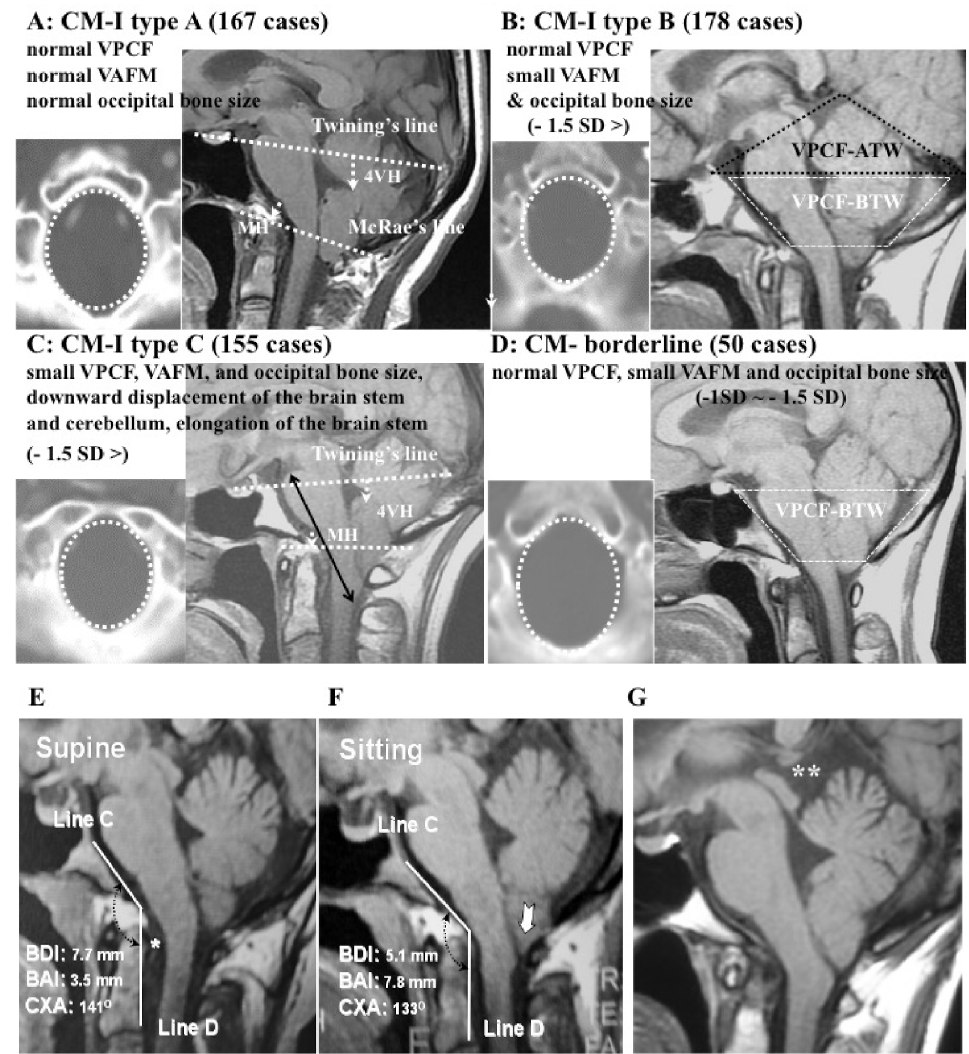
Figure 1. Illustrative cases: CM-I subtypes. ( A ): CM-I type A, ( B ): CM-I type B, ( C ): CM-I type C, and ( D ): CM-borderline. Left panel: 2D CT axial image at the level of the foramen magnum; right panel: magnetic resonance (MR) sagittal midline image. ( E , F ): MR midsagittal images demonstrating the character of CM-I type with HDCT. VPCF, VAFM, and occipital bone size are normal in size. ( E ): MR midsagittal image in supine position showing normal interval BDI (7.7 mm), normal BAI (3.5 mm), normal CXA) (141 ◦ ), large retro-odontoid pannus (asterisk), and low-lying cerebellar tonsils. ( F ): Upon observation of the upright position, there is evidence of cranial settling (2.5 mm decrease in BDI), posterior gliding of occipital condyle, 4.3 mm increase in BAI, anterior flexion of the occipito– atlantal joint (decrease of 8 ◦ in CXA), and increased cerebellar ptosis with downward displacement cerebellar tonsils to C1 (white arrow). Note the significantly increased impaction of the foramen magnum anteriorly and posteriorly. Bilateral black dotted arrow = CXA, white arrow = tonsillar herniation. ( G ): MR midsagittal image demonstrating the character of CM-I type A with TCS. VPCF, VAFM, and occipital bone size are normal in size. MR image showing elongation and downward displacement of the brainstem and cerebellum, as well as large supracerebellar cistern (double asterisk). Abbreviations: CM-I = Chiari malformation type I, BDI = the interval between basion and dens, BAI = the interval between basion and atlas, CXA = the clivo-axial angle, HDCT = hereditary disorders of connective tissue, TCS = tethered cord